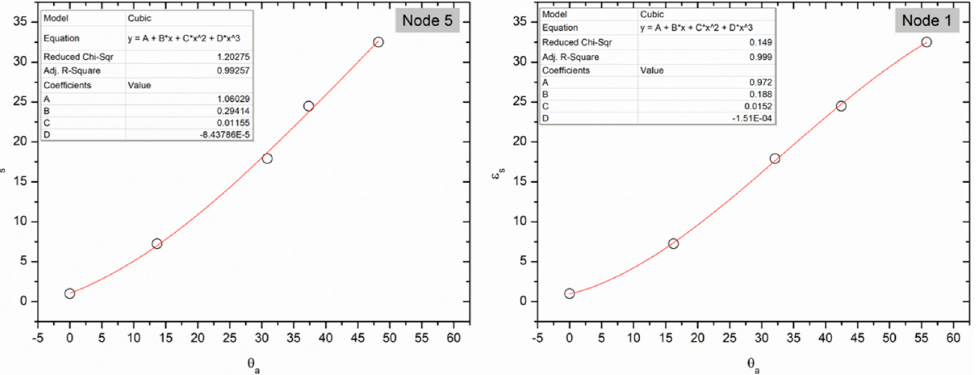
Figure 2. Example of unit-specific standardization equations in ε standards. Insets show equation coefficients.